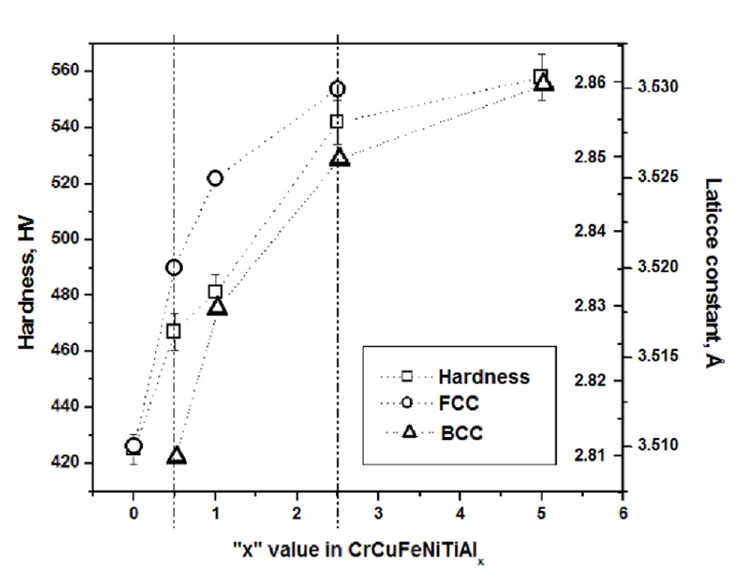
Figure 2. Microhardness results in Vickers scale (average and standard deviation) and lattice constant of the CrCuFeNiTiAl x alloy, both presented as a function of aluminum